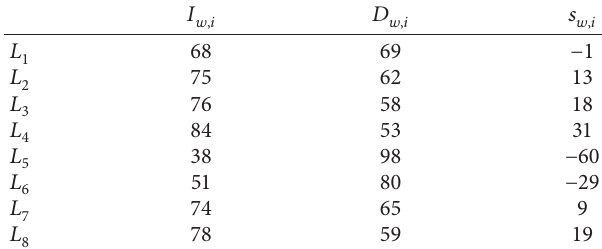
Table 4: The weighted impact indicator, the weighted divider indicator, and the weighted score values of each choice in Example 3. I